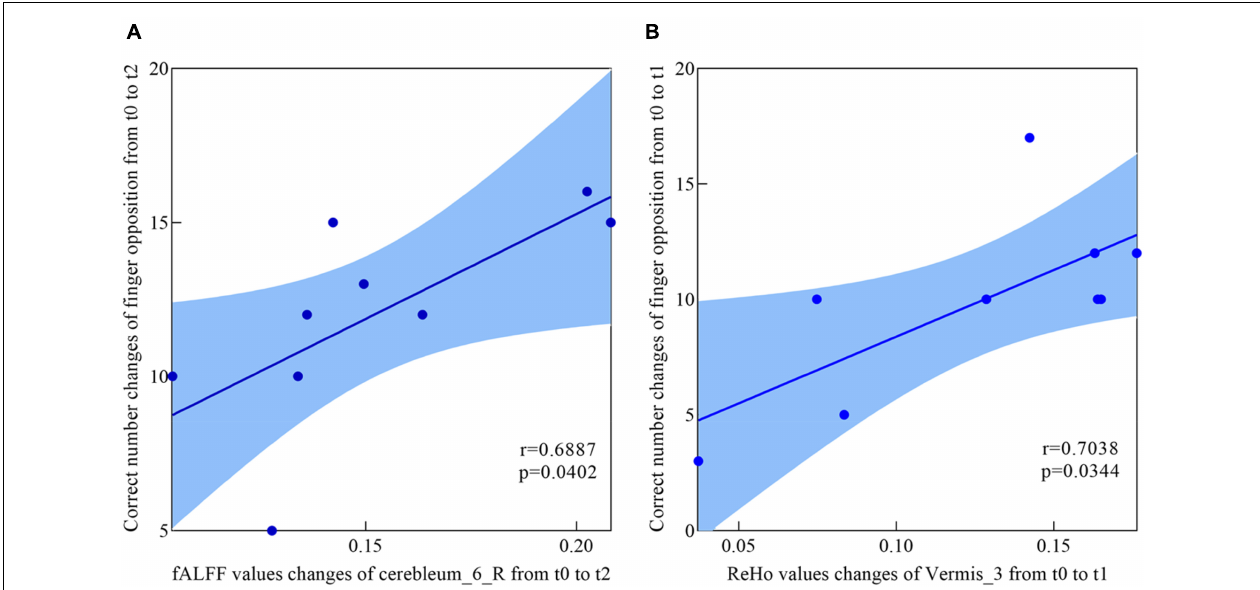
FIGURE 5 | Correlations between fALFF values, ReHo values, and behavioral scores. (A) The participants showed a significantly positive correlation between the fALFF values increased in Cerebelum_6_R and the enhancement of behavioral performance (the changes of in correct finger opposition number) from t0 to t2. (B) Significantly positive correlation between the ReHo values increased in Vermis_3 and the enhancement of behavioral performance (the changes of in correct finger opposition number) from t0 to t1.